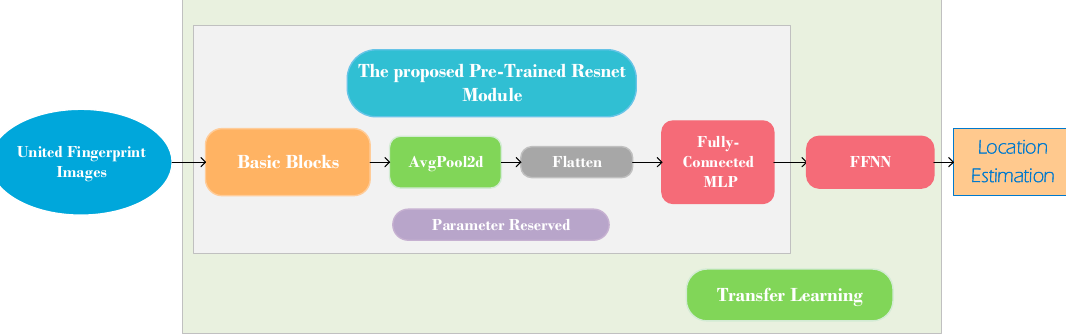
Figure 10. Architecture of proposed DNN positioning method. The positioning system consists of two parts: Resnet-based localizer and feed-forward neural network (FFNN)-based fine localizer. Table 2. Testing configurations for performance evaluation. Adam, adaptive moment estimation; scaled exponential linear unit (SELU), scaled exponential linear unit.